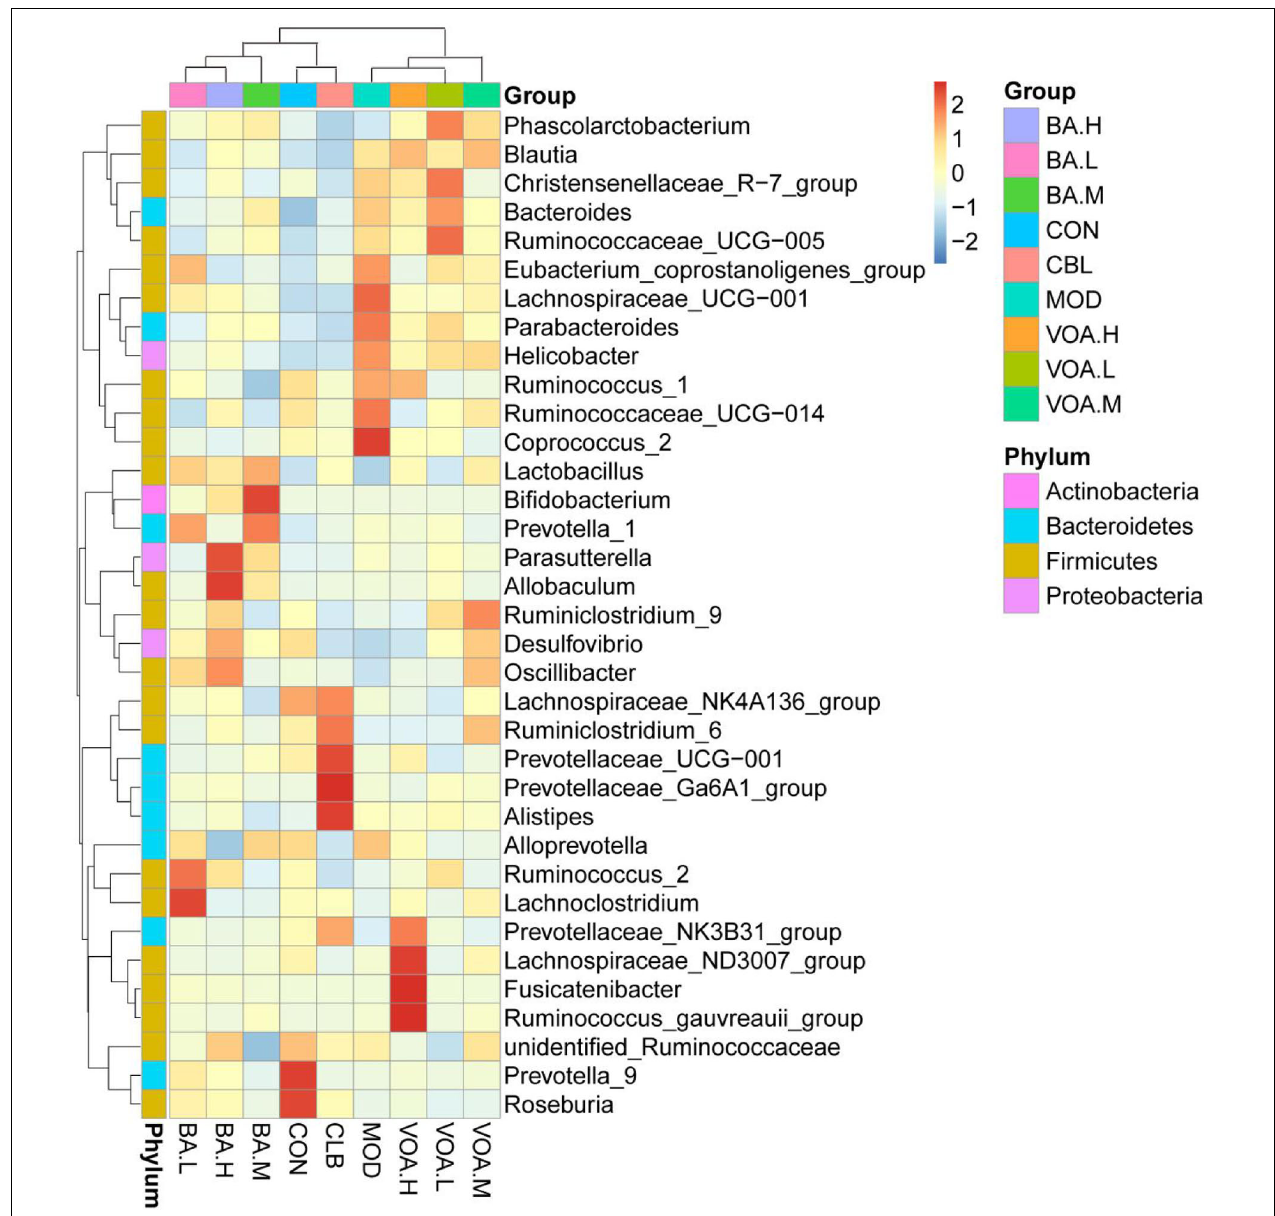
FIGURE 9 | Species abundance clustering at the genus level. The X -axis represents sample information, the Y -axis represents annotation information for species, the clustering tree on the left is the species clustering, and the upper area is the sample clustering. Center values are Z -values standardized for species abundance in each